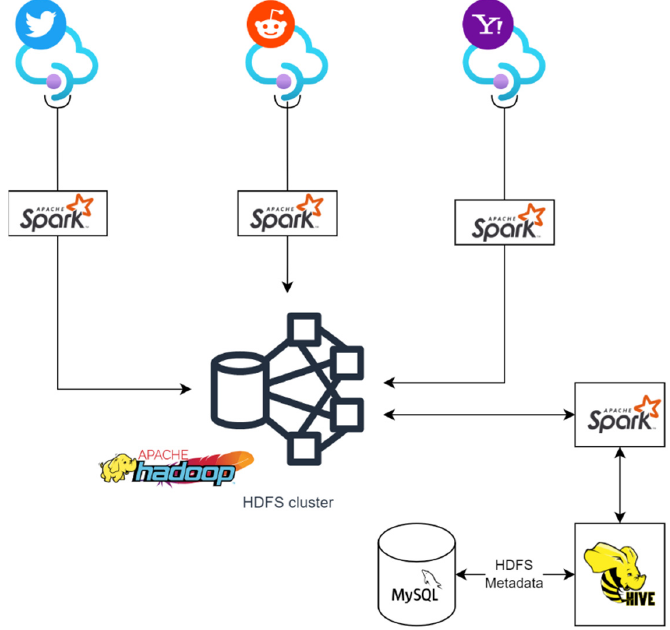
Figure 8. Big Data storage architecture. Figure 8. Implemented LSTM - CNN with stock data.